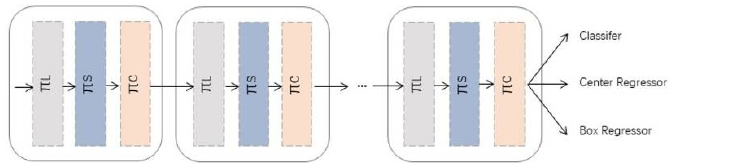
Figure 8. An example of applying Dynamic Head blocks to a one-stage object detector [23].